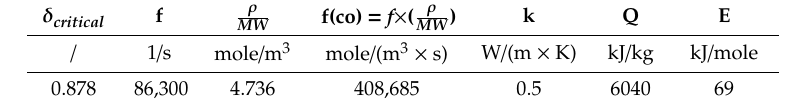
Table 1. The properties of the mixture of sand and oil.